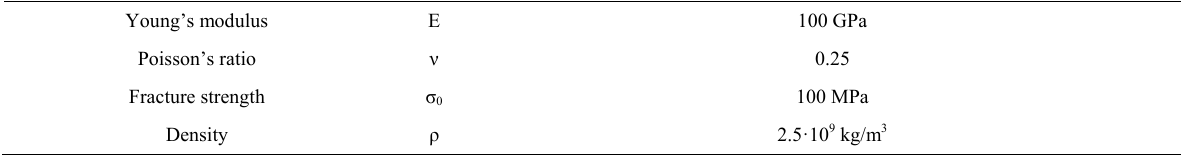
Table 2: Material properties for unit element example.